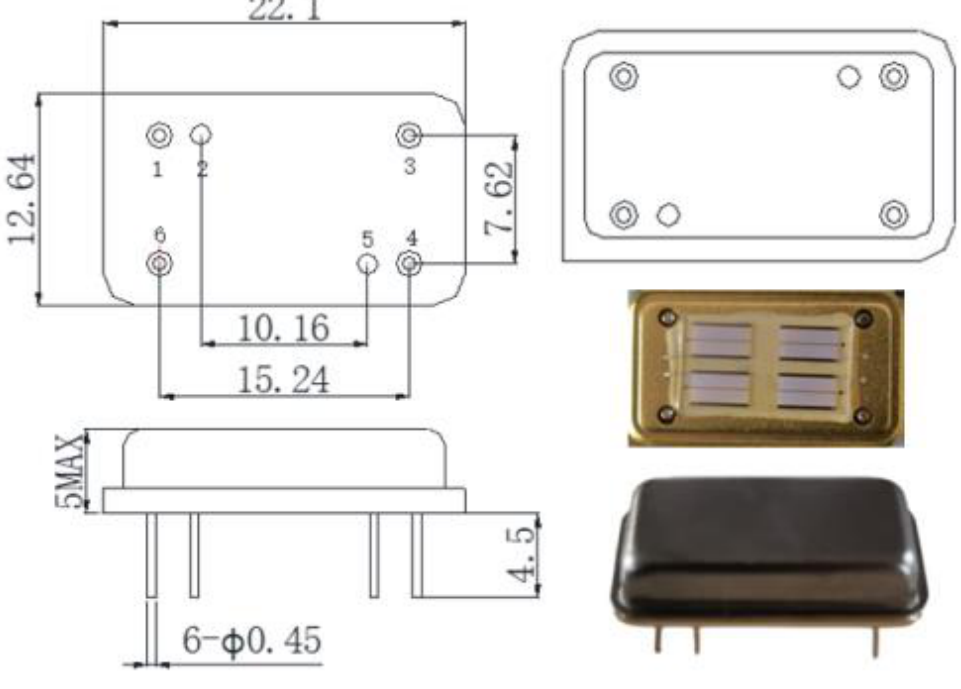
Figure 2. Device size and physical drawing.